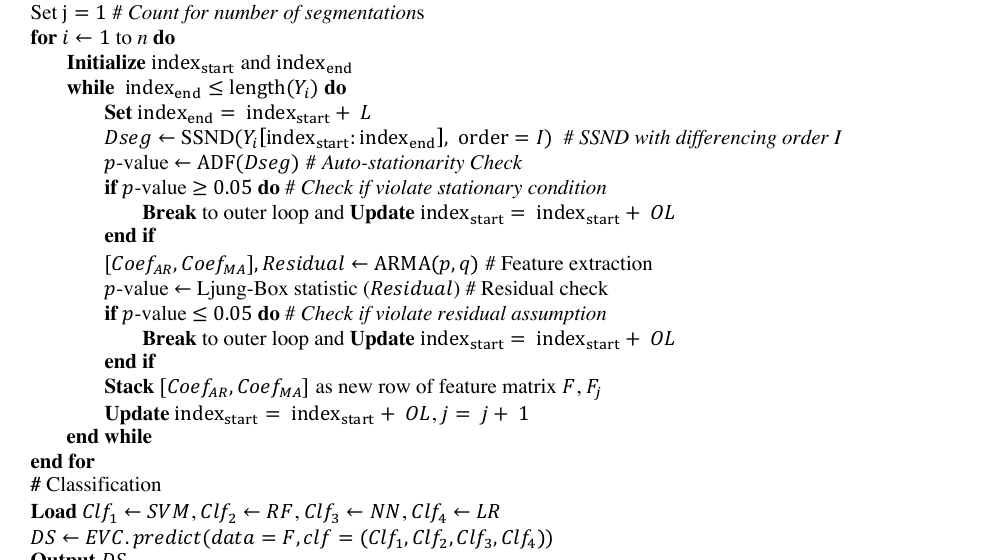
Figure 3. Pseudo-code of the trained ARIMA-ML framework